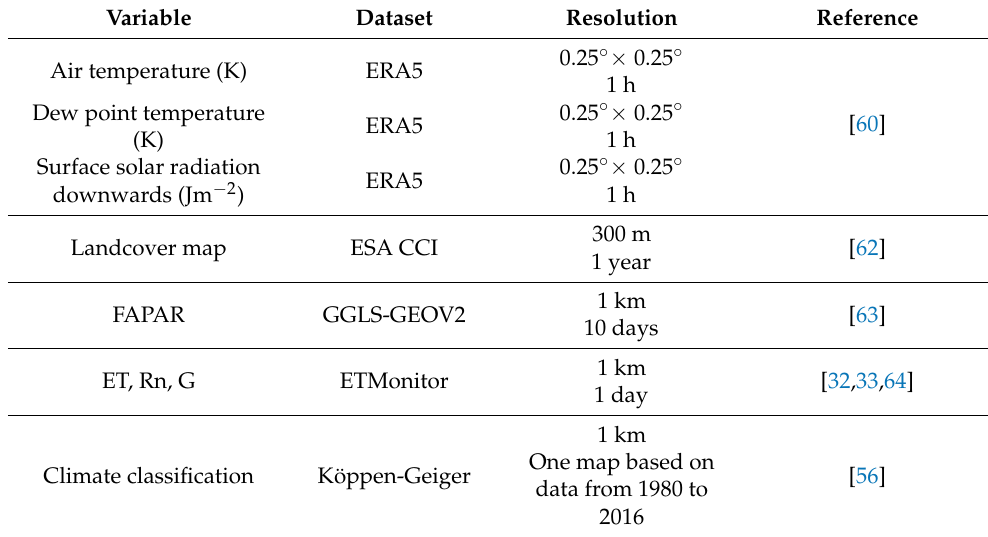
Table 3. Input datasets used to drive the EF-LUE model for global GPP estimate in this study. Variable Dataset Resolution Reference